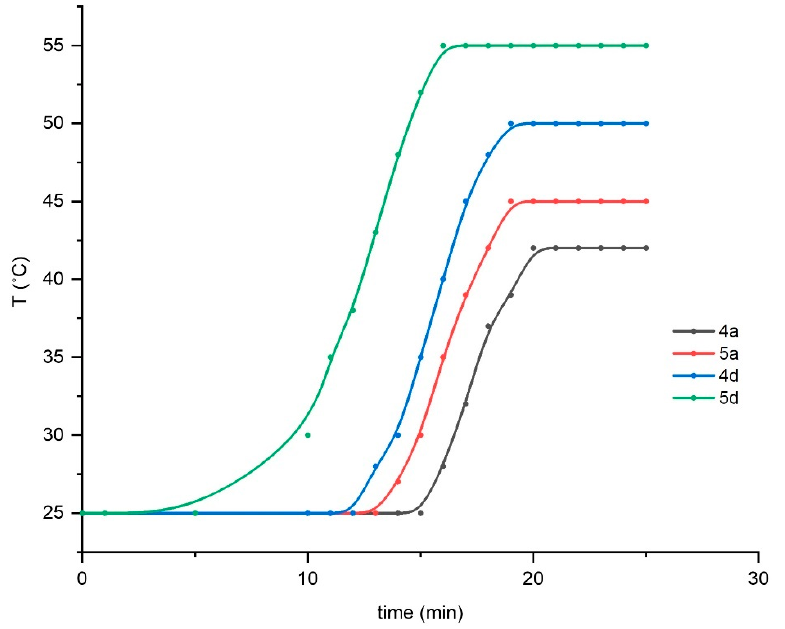
Figure 6. Exotherms of ROMP reactions of DBNB (10 g, 0.05 mol) under the action of catalysts 4a , 4d , 5a , and 5d . Reaction conditions: catalyst loading is 0.1 mol% (0.008 mmol), starting temperature is 25 °C, neat.